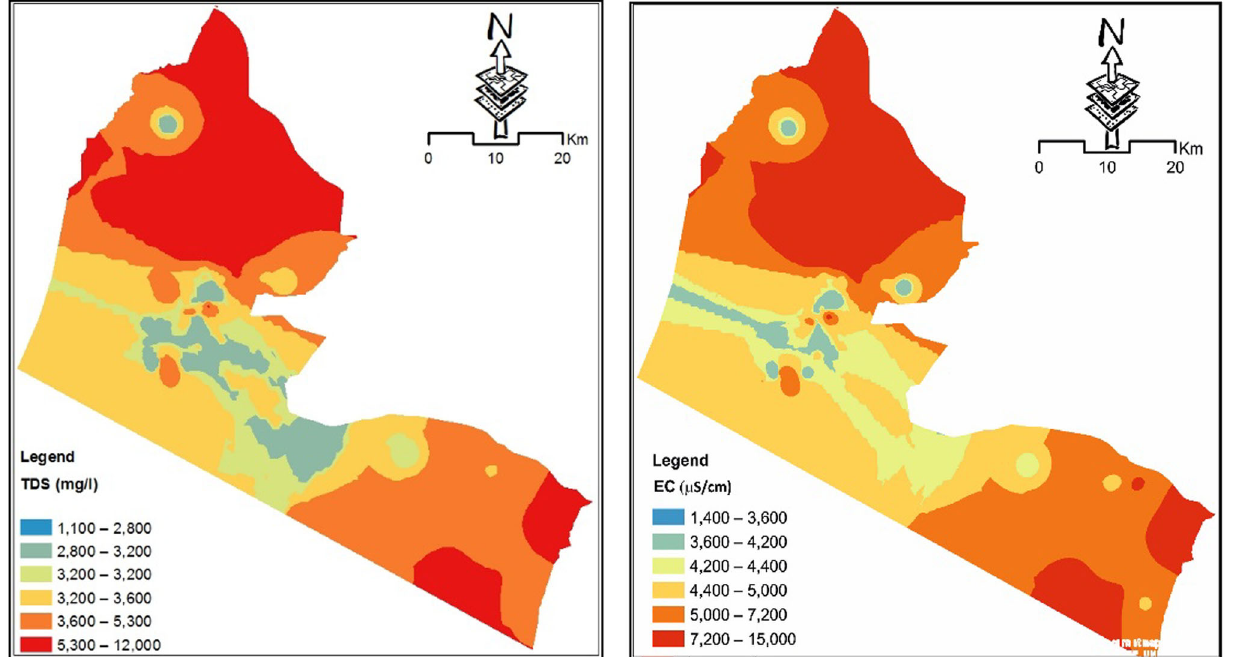
Fig. 5 Distribution pattern of electrical conductivity ( l S/cm) and total dissolved solids